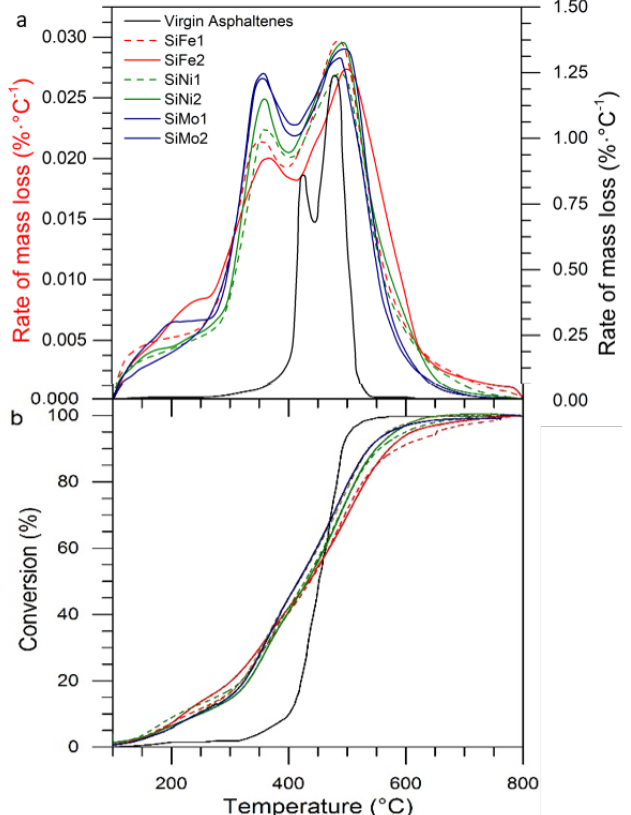
Figure 17. ( a ) The rate of mass loss as a function of temperature (DTG) and ( b ) conversion of virgin asphaltenes in the presence of one transition element. Adsorbed asphaltenes were present at 0.2 mg · m − 2 ; asphaltenes in the presence of one transition element . Adsorbed asphaltenes were present at 0.2 heating rate is 10 ◦ C · min − 1 mg·m −2 ; heating rate is 10 °C·min −1.